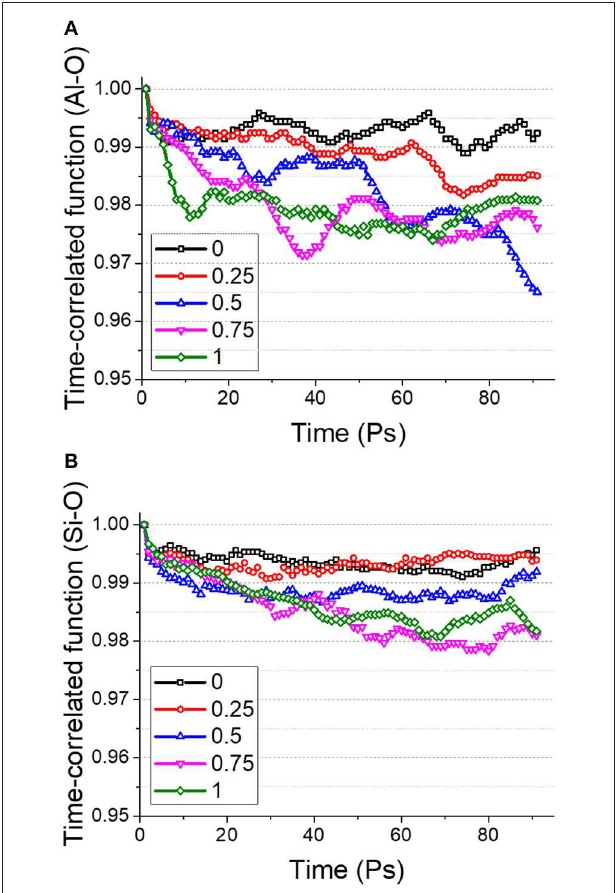
FIGURE 5 | Time-correlated function of (A) Al-O and (B) Si-O bonds.